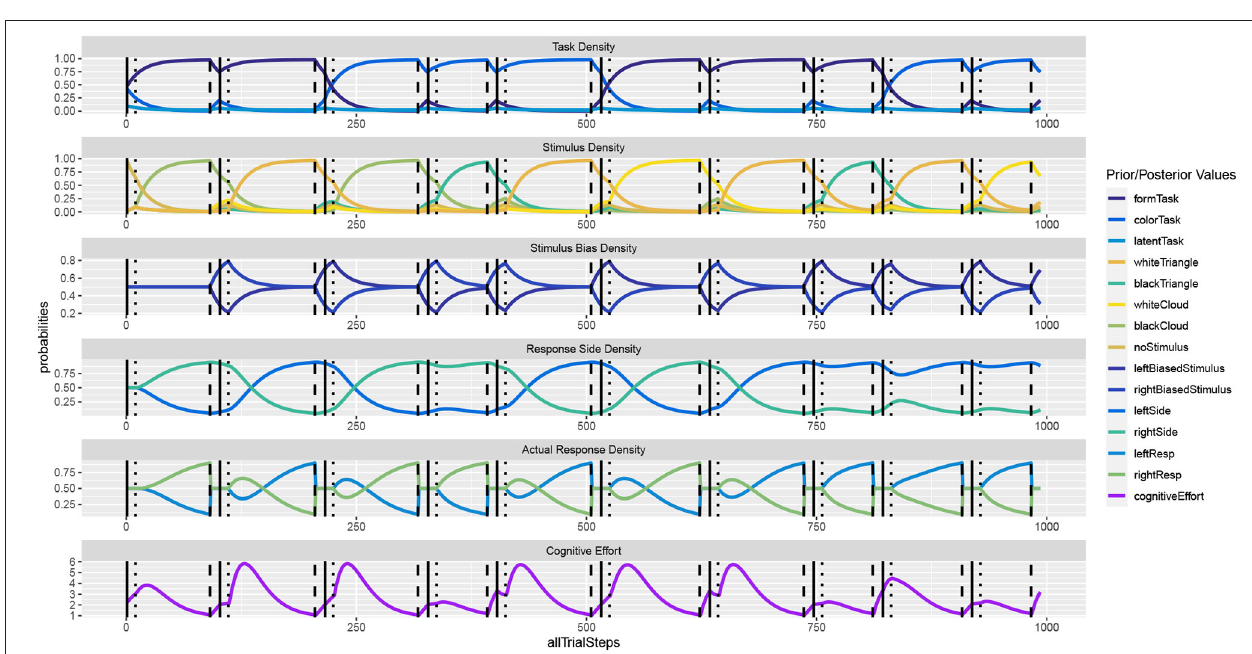
FIGURE 3 | In the Simon effect , the reaction times clearly depend on the stimulus bias, favoring ipsilateral responses. Besides the mean reaction times, the values report standard error, the number of condition-respective trials, and mean cognitive effort costs C (task) integrated over the time from the stimulus onset until the